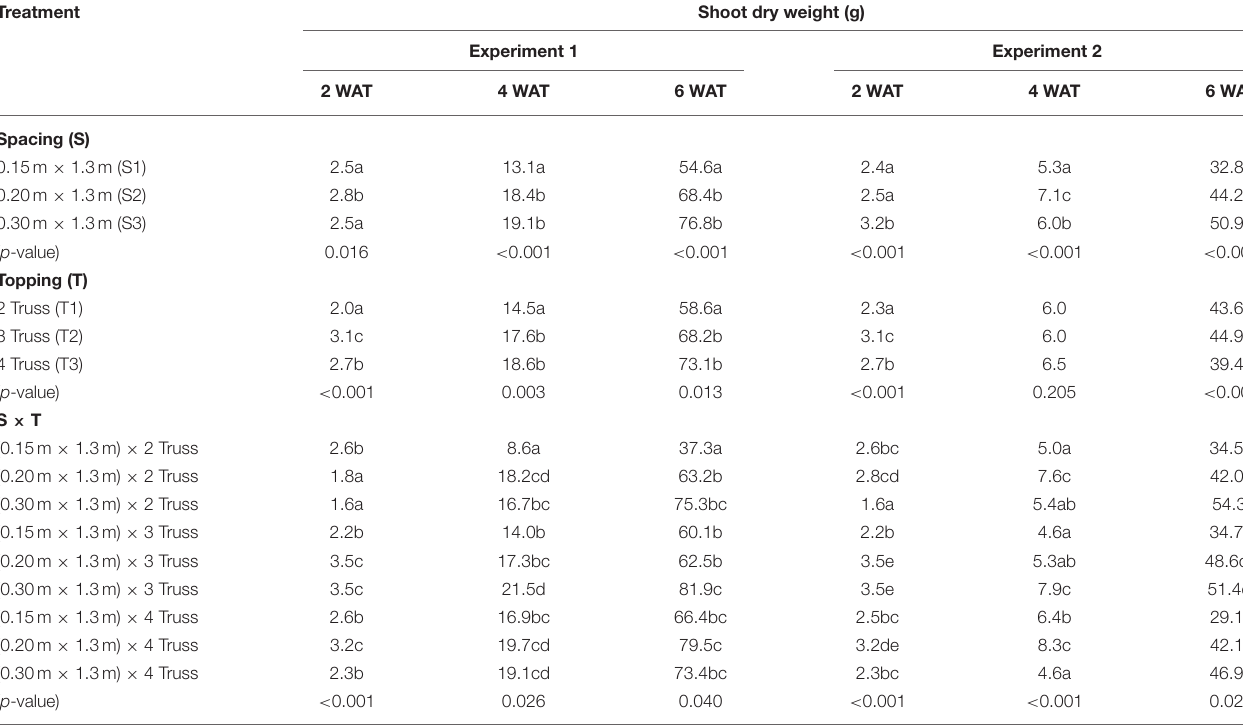
TABLE 4 | Effect of spacing and topping on plant shoot dry weight of Solanum lycopersicum under greenhouse conditions.